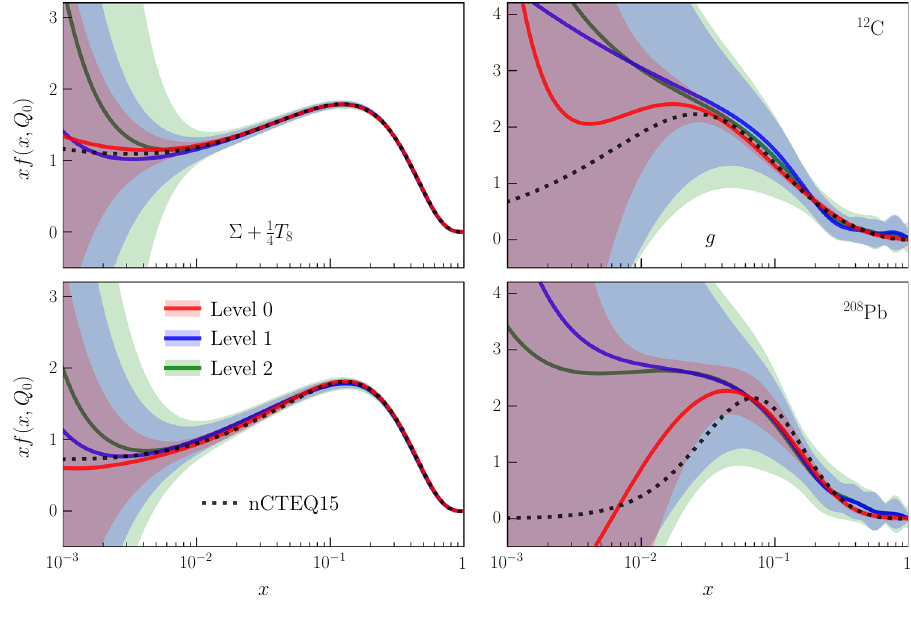
Fig. 11 Same as Fig. 8, but now showing together the results of the L0 (red), L1 (blue), and L2 (green) closure